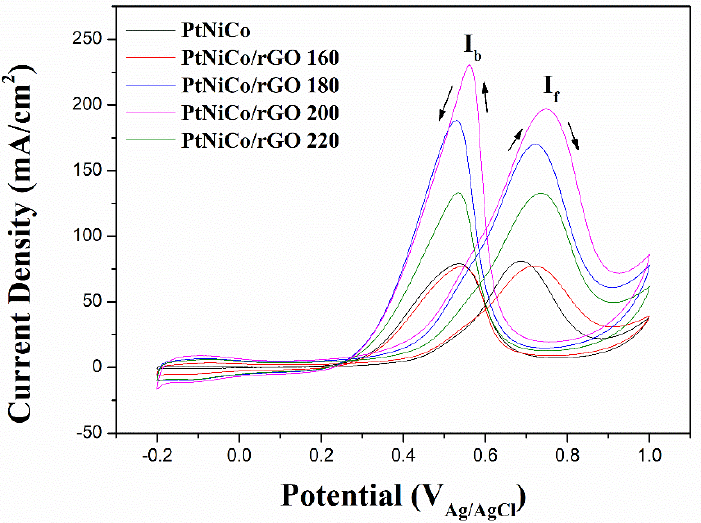
Figure 8. CV curves of methanol oxidation on PtNi 2 Co/rGO, PtNiCo/rGO, PtNiCo, and PtNiCo 2 /rGO in N 2 -saturated 0.5 M H 2 SO 4 + 1.0 M CH 3 OH solution, sweep rate 20 mV/s.